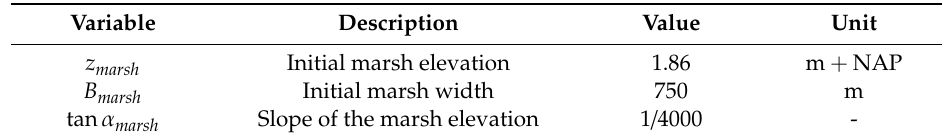
Table A2. Marsh profile parameters.